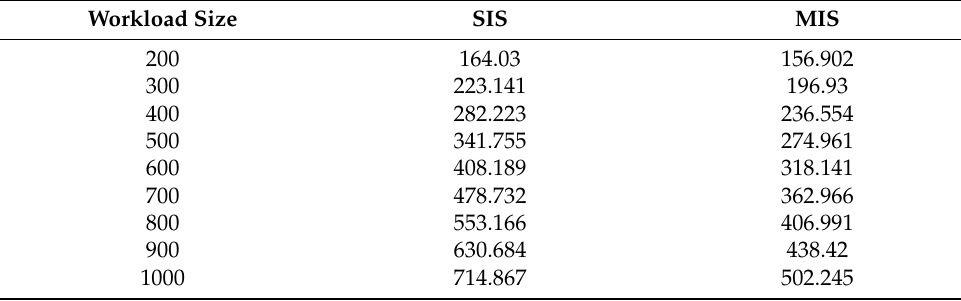
Table 3. Experimental results—comparison between SIS and